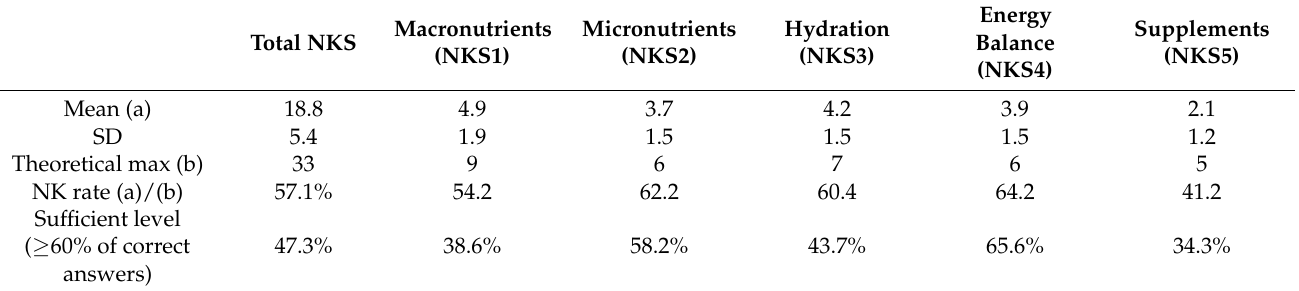
Table 5. Sport nutrition knowledge assessment of the sample ( n =